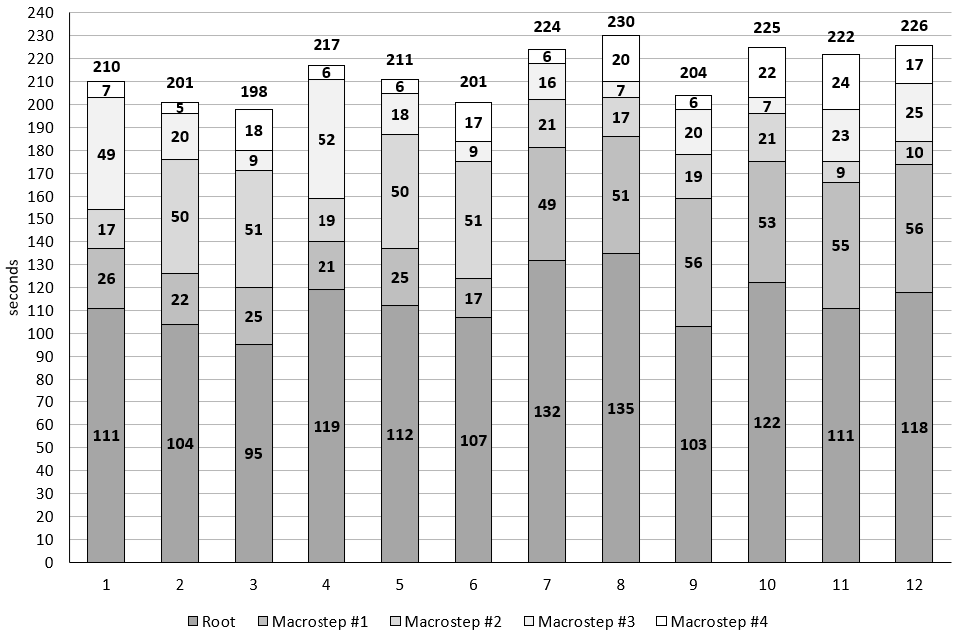
Figure 9. Macrostep periods in each execution path of the 3VM